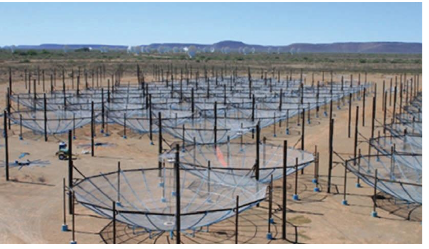
Figure 15: Hydrogen epoch of reionization array (https://caes. ukzn.ac.za/news/frst-data-release-from-hera-team-gives-insight- into-the-early-universe/).